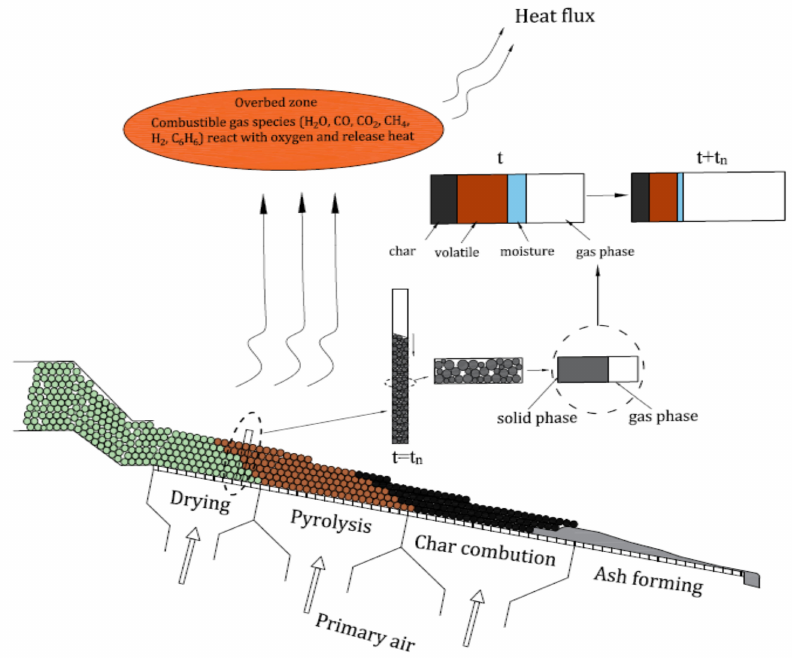
Figure 2. One-dimensional walking column method for moving-grate biomass combustor modeling. The solid and gas phase governing equations used in this work are demonstrated in Table 1. Other information related to the modeling, such as kinetic formula of subprocesses, coe ffi cients of specific heat, conductivity, source terms of governing equations, and so on, are presented in Table 2. Gas pressure drop for laminar flow in the packed fuel bed is also introduced in Table 2, where L is the fuel bed height, g c is the gravitational constant, ε is e ff ective porosity, µ air is absolute viscosity, ν is air velocity, d p is e ff ective particle diameter, and ρ is air density